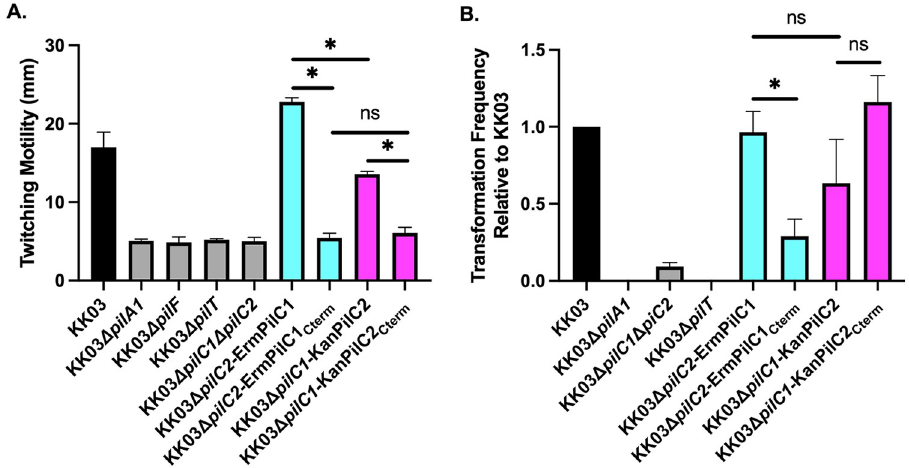
Fig 6. The PilC1 and PilC2 C-terminal domains are not sufficient for twitching motility but promote K . kingae natural transformation. (A) For strains KK03, KK03 Δ pilA1 , KK03 Δ pilF , KK03 Δ pilT , KK03 Δ pilC1 Δ pilC2 , KK03 Δ pilC2 -ErmPilC1, KK03 Δ pilC2- ErmPilC1 Cterm , KK03 Δ pilC1- KanPilC2, and KK03 Δ pilC1 -KanPilC2 Cterm , the zone of twitching motility was stained with crystal violet and was quantified by measuring the diameter of bacterial spread. (B) Natural transformation was measured for strains KK03, KK03 Δ pilA1 , KK03 Δ pilC1 Δ pilC2 ,KK03 Δ pilT , KK03 Δ pilC2- ErmPilC1, KK03 Δ pilC2- ErmPilC1 Cterm , KK03 Δ pilC1- KanPilC2, and KK03 Δ pilC1 -KanPilC2 Cterm . Transformation frequency was calculated based on the ratio of recovered bacteria to inoculum. Error bars represent standard error of the mean, n = 3. Cyan color denotes strains expressing either full-length PilC1 or the C-terminal region of PilC1 only. Magenta color denotes strains expressing either full-length PilC2 or the C-terminal region of PilC2 only. � indicates significance of P < 0.05 as determined by a one-way ANOVA using Bonferroni correction for multiple comparisons. ns indicates no